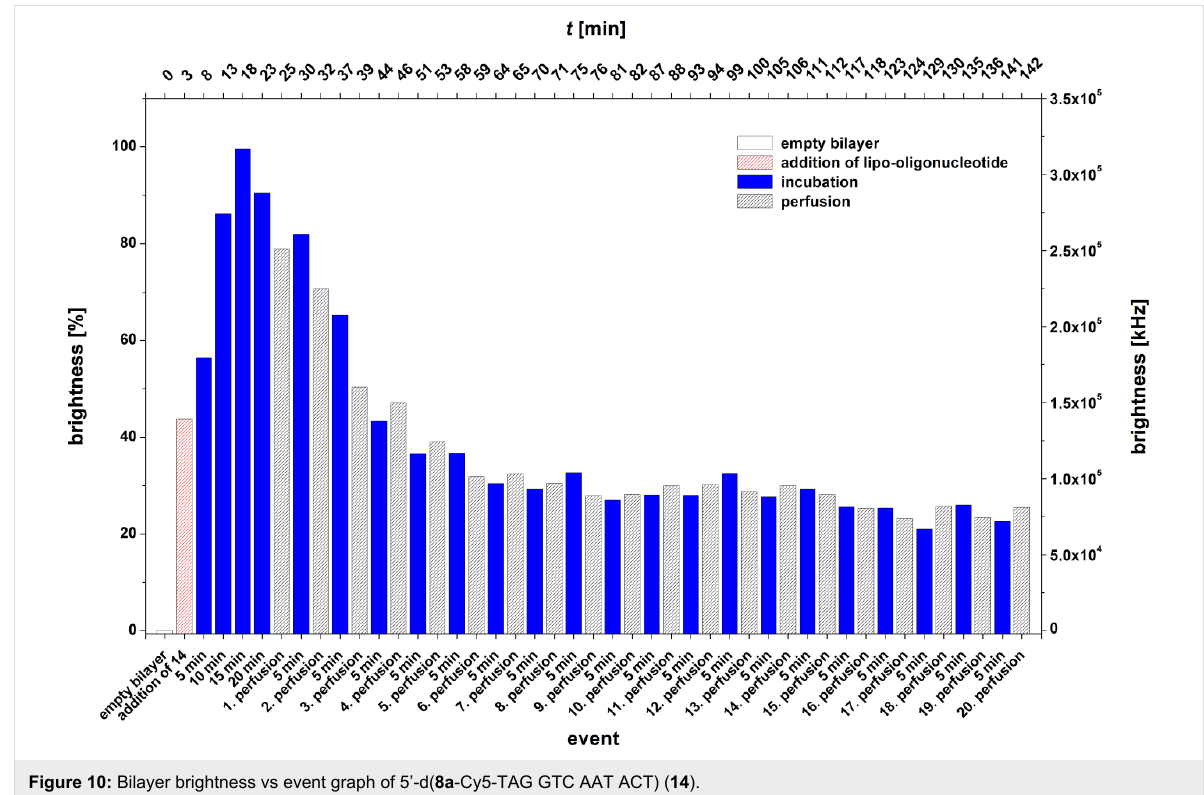
Figure 10: Bilayer brightness vs event graph of 5’-d( 8a -Cy5-TAG GTC AAT ACT) ( 14 ).